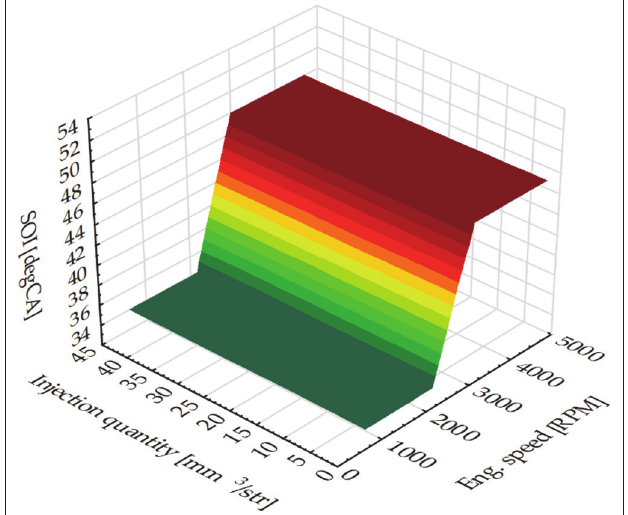
Figure 4. Series map SOI.